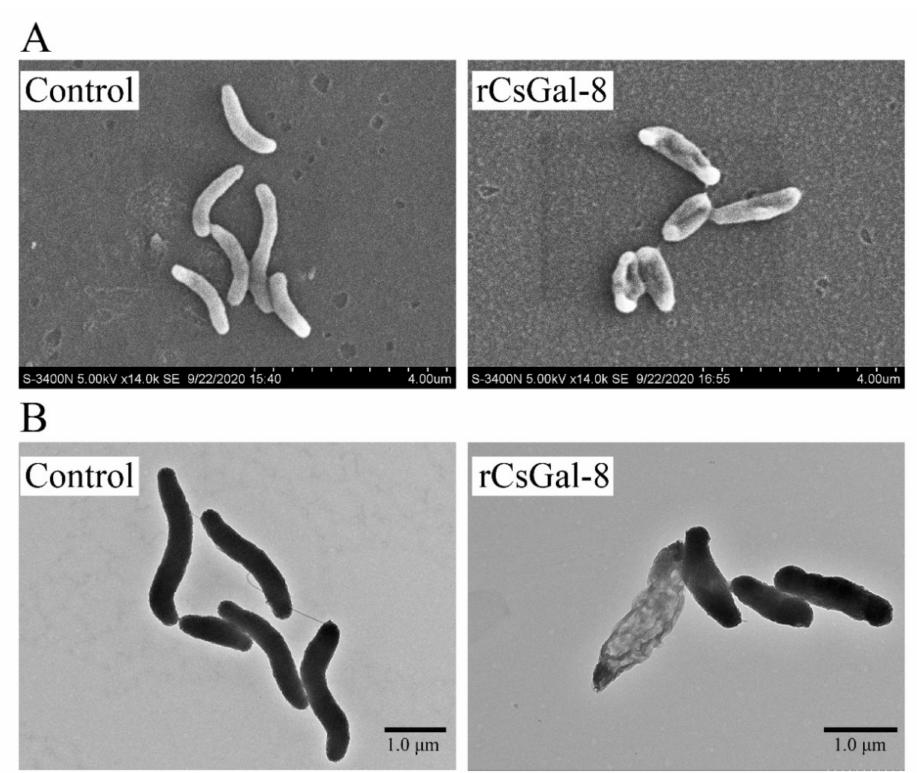
Figure 10. Ultra-structural analysis of rCsGal-8-treated Vibrio anguillarum . V. anguillarum was incubated with 1 µ M rCsGal-8 or PBS (control) for 30 min and then examined with scanning electron microscopy ( A ) and transmission electron microscopy ( B